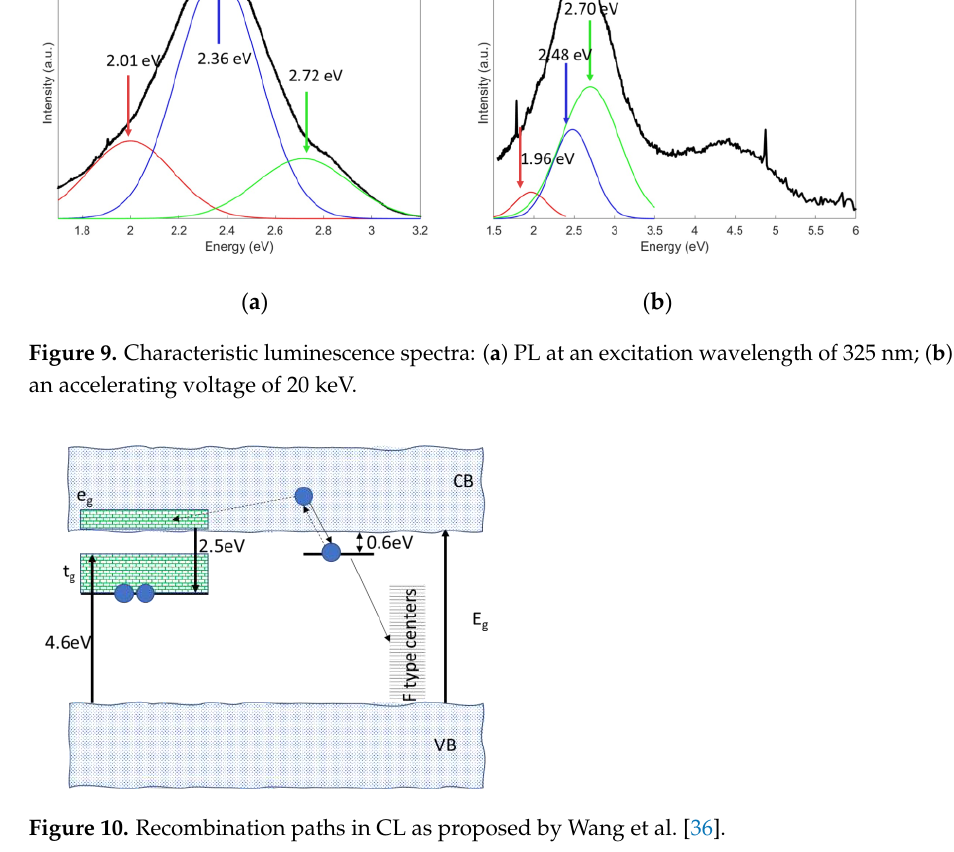
Figure 10. Recombination paths in CL as proposed by Wang et al. [36]. Finally, the band observed in the CL spectrum centered at 4.5 eV (Figure 9b) could also be associated with these kind of complex centers